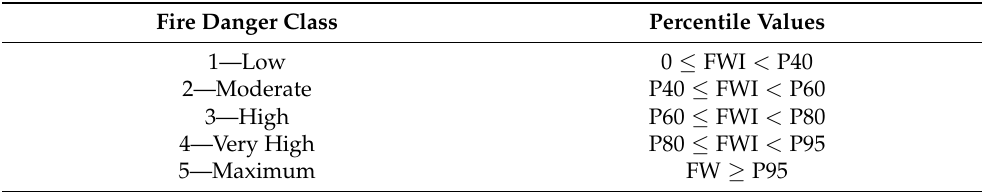
Table 2. Percentile values of FWI used for the initial proposal.